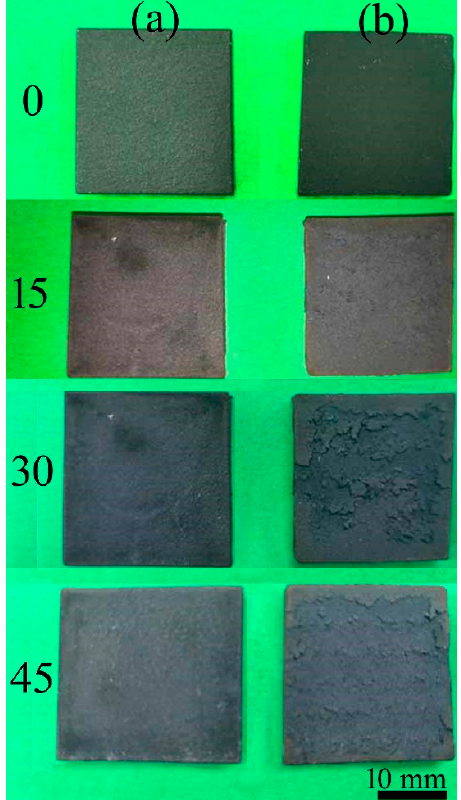
Figure 10. Surface morphologies of the coatings prepared at ( a ) optimized and ( b ) nonoptimized parameters after 0, 15, 30, and 45 times of heat shock.